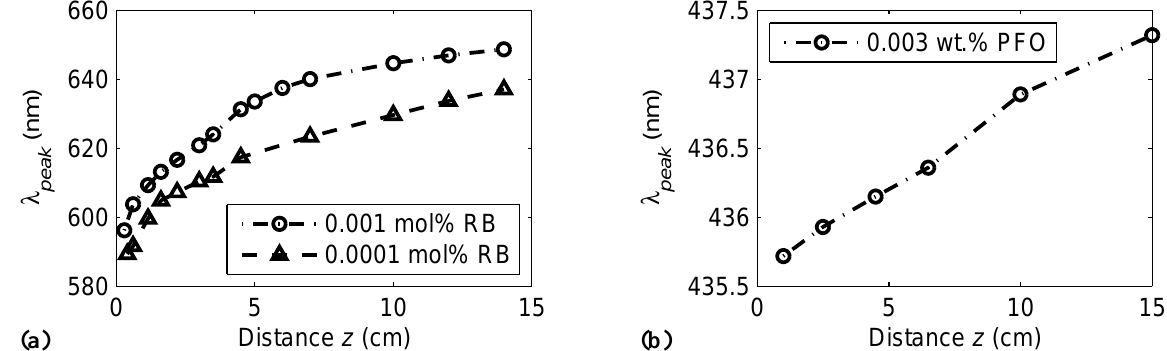
Figure 4. Peak wavelength as a function of fiber length below threshold: ( a ) for RB-doped fibers (pump energy density 8 μ J/mm 2 as in the experiments, dye concentrations inset); ( b ) for PFO-doped fibers (pump pulse energy density 0.69 μ J/mm 2 as in the experiments, dye concentration inset).